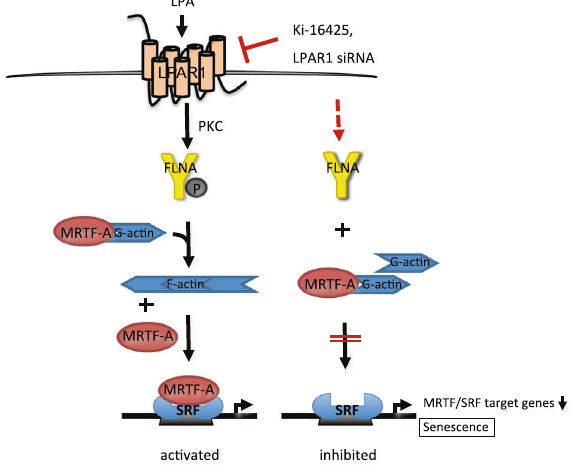
Fig. 7 Model for LPAR1 regulation of FLNA and MRTF-A transcriptional activity. LPA induction leads to PKC activation and phosphorylation of FLNA at S2152, resulting in complex formation with MRTF-A and LPAR1 which triggers actin polymerization, resulting in dissociation of the repressive MRTF-A – G-actin complex and transcriptional activation of SRF. Depletion of LPAR1 inhibits FLNA phosphorylation at S2152, prevents complex formation with MRTF-A, inhibits MRTF/SRF target gene expression, and